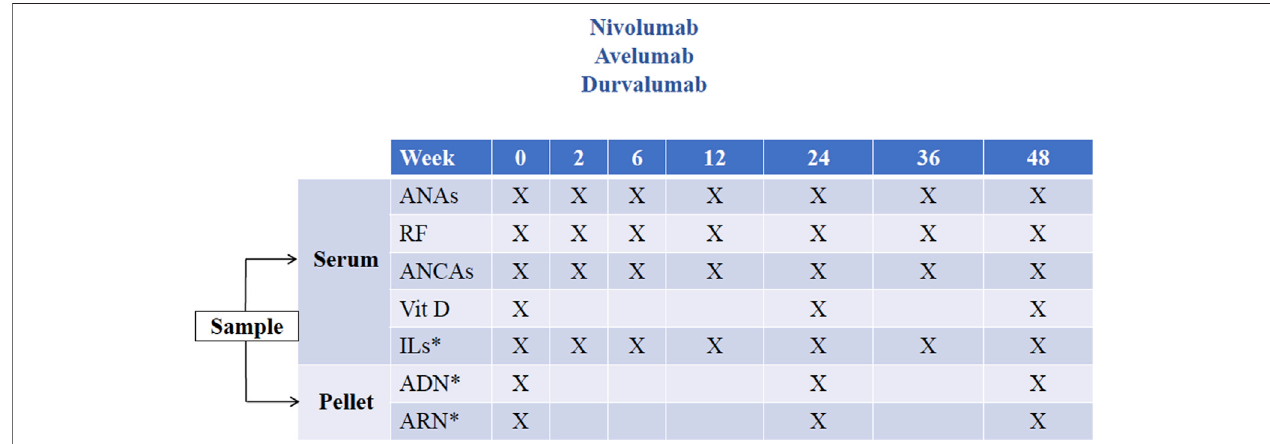
FIGURE 1 | Study schedule 1. Timing of ordinary samples for patients included receiving immune checkpoint inhibitors administered every 2 weeks (nivolumab, avelumab, and durvalumab). *Measurementsnotincludedinthis study (potentially foruse infuture research projects). ANA,antinuclearantibody; RF, rheumatoid factor; ANCA, antineutrophil cytoplasmic antibody; Vit D, vitamin D (measured as 25-hydroxycholecalciferol); IL, interleukin.